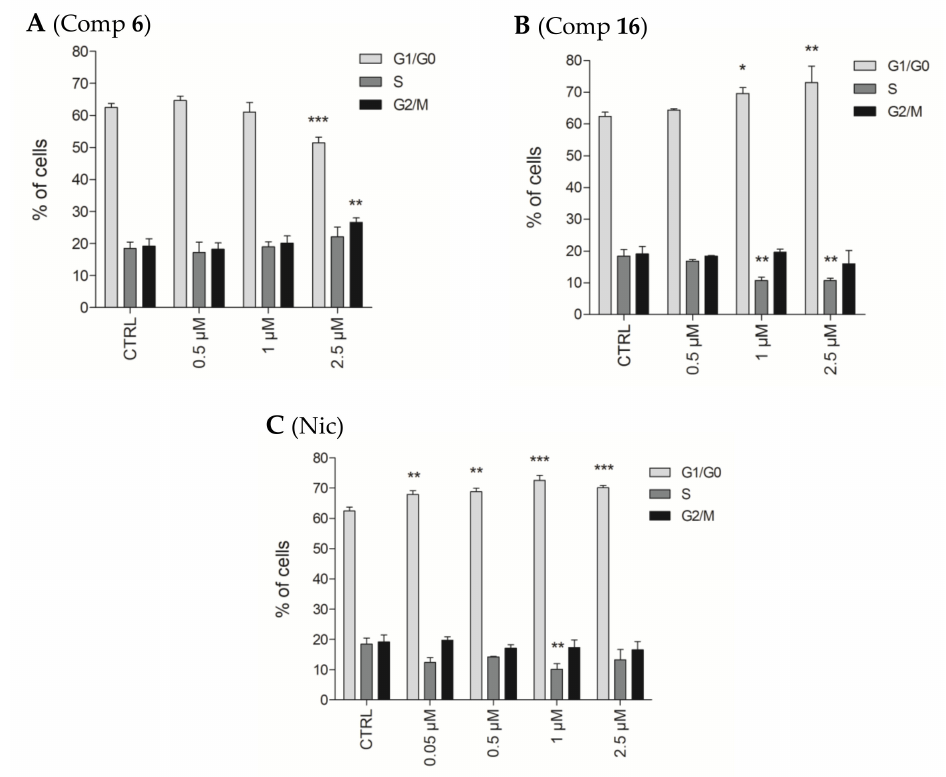
Figure 7. Distribution of DU145 cells in cell cycle phases after 48 h treatment with each compound. Results are expressed as the mean ± SD from three independent experiments. * p < 0.05, ** p < 0.01, *** p < 0.001, significantly different from drug-free control (CTRL). ( A ) shows the results obtained with 6 ; ( B ), results obtained with 16, and ( C ) results obtained with